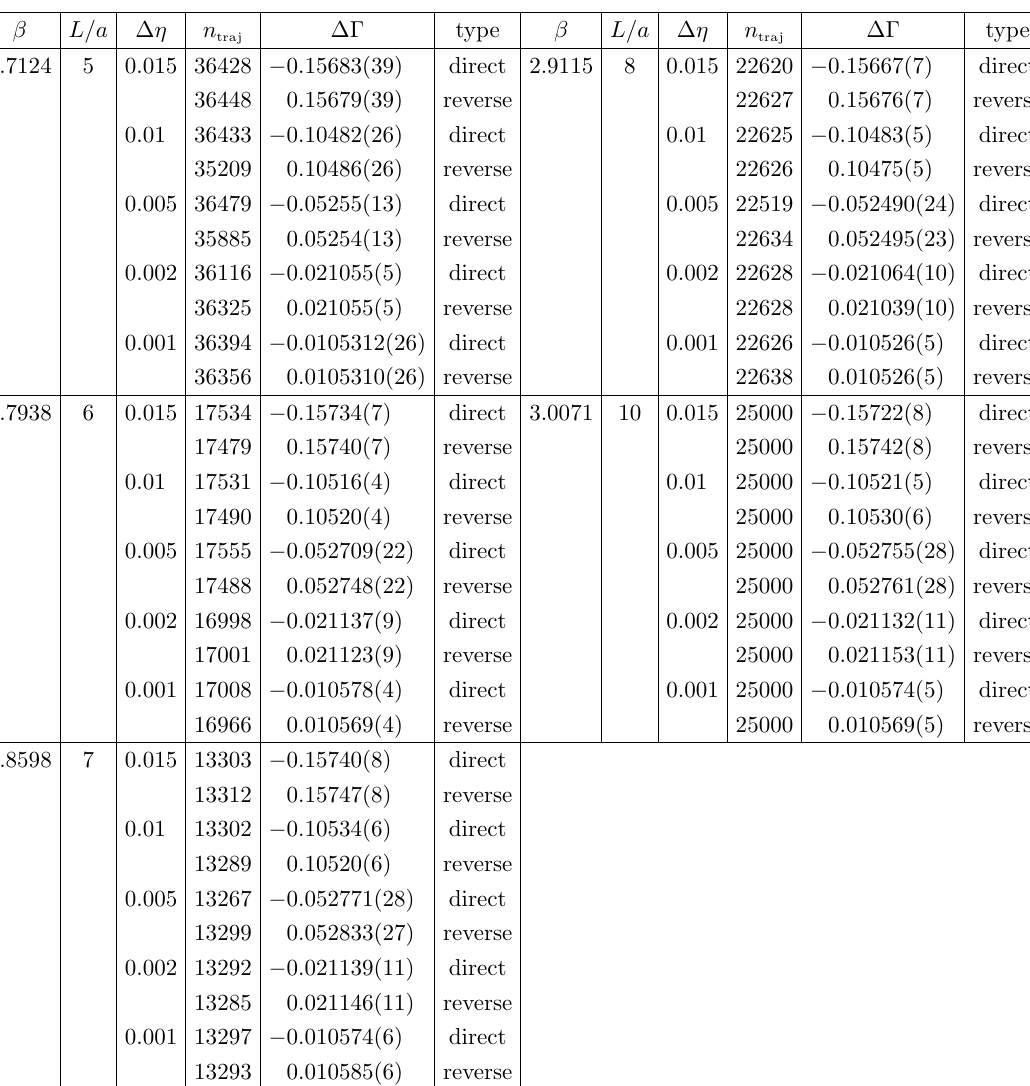
Table 1 . Results for the e(cid:11)ective-action variation (cid:1)(cid:0) in SU(2) gauge theory at (cid:12)ve di(cid:11)erent combinations of (cid:12) and L (corresponding to the last series reported in ref. [31, table 2]) and for di(cid:11)erent values of (cid:1) (cid:17) , in direct and in reverse non-equilibrium trajectories. These simulations were run with n = 200, with the number of trajectories denoted by n qq